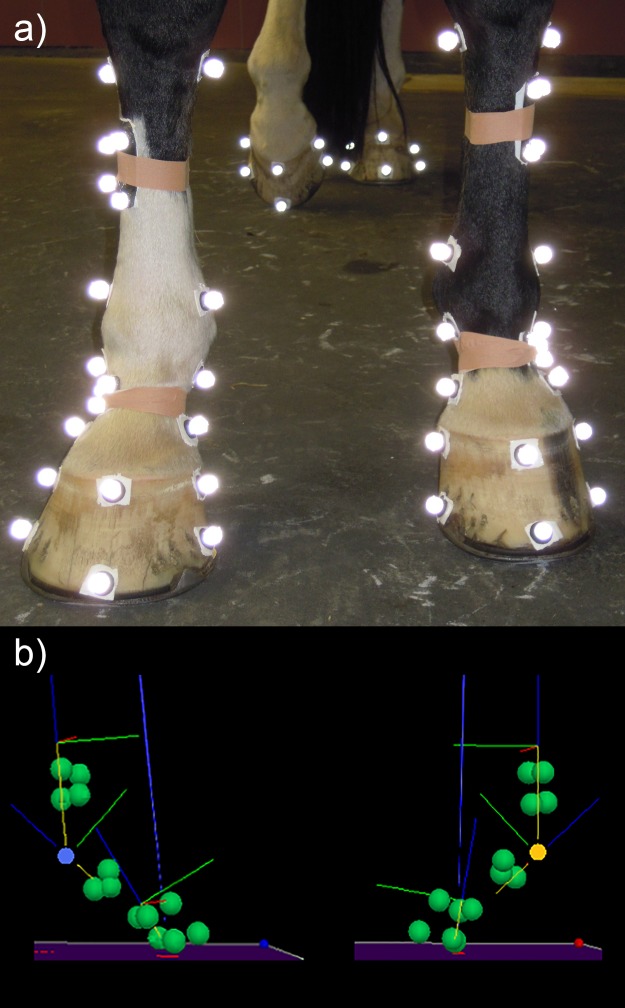
Photograph and three-dimensional reconstruction of one uneven footed horse showing the marker set used in the study.a) A photograph showing the anatomical and tracking markers used for the study. The photograph illustrates the definition of a horse with uneven feet where the right forelimb has a lower hoof angle (LHA) and the left forelimb has a higher hoof angle (HHA). b) An example of the functional consequences of unevenness in one horse with a difference in dorsal hoof wall angle of 8 degrees. Three-dimensional reconstruction of the left and right forelimbs in the position of maximum vertical MCPJ displacement. The blue and yellow circles show the position of the MCPJ and the blue line originating from the centre of the foot is the resultant force vector. The hoof on the left is the lower hoof angle (LHA; blue: RF) and the hoof on the right is the higher hoof angle (HHA; yellow: LF).